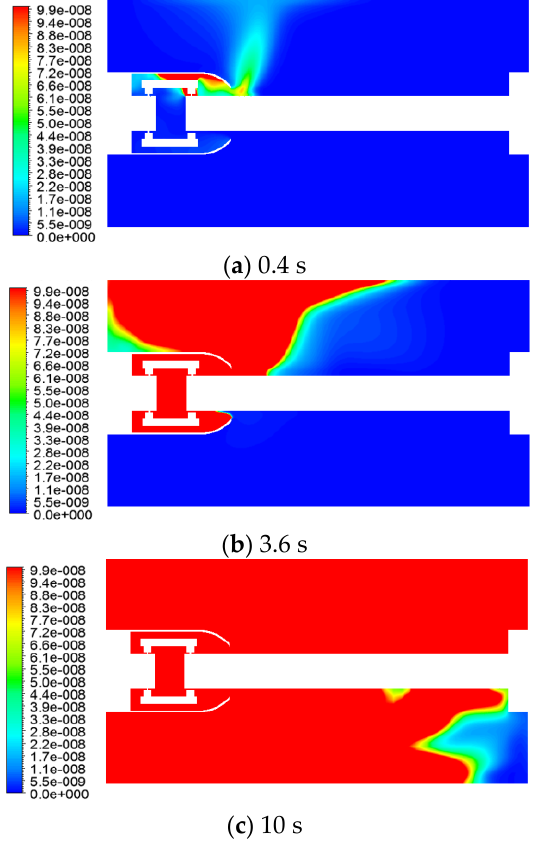
Figure 10. Variation of the SO 2 mass fraction with time.